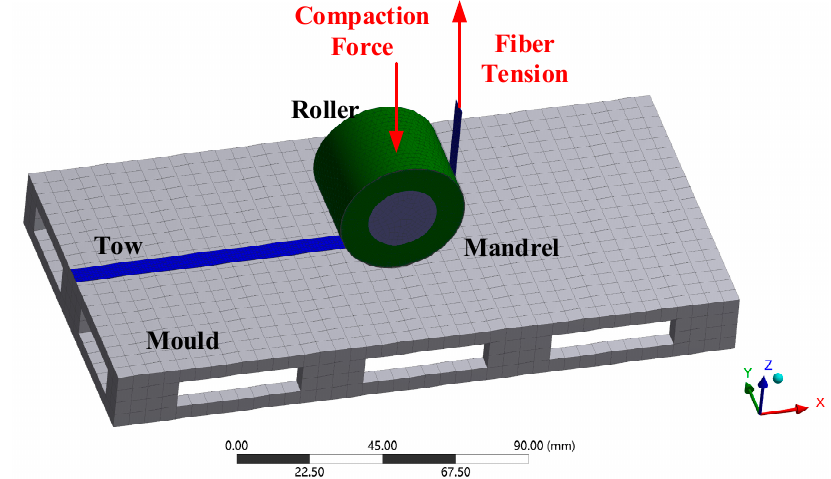
Figure 6. Simulation model of compaction contact.